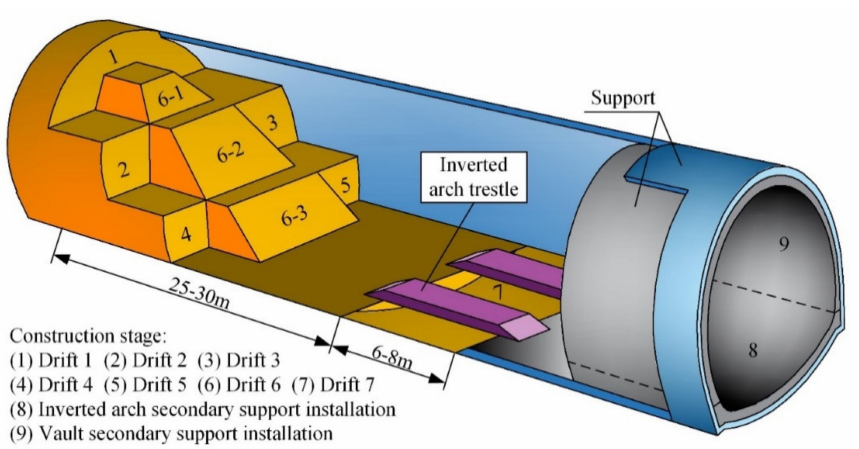
Figure 5. Longitudinal perspective of three-bench seven-step excavation method.